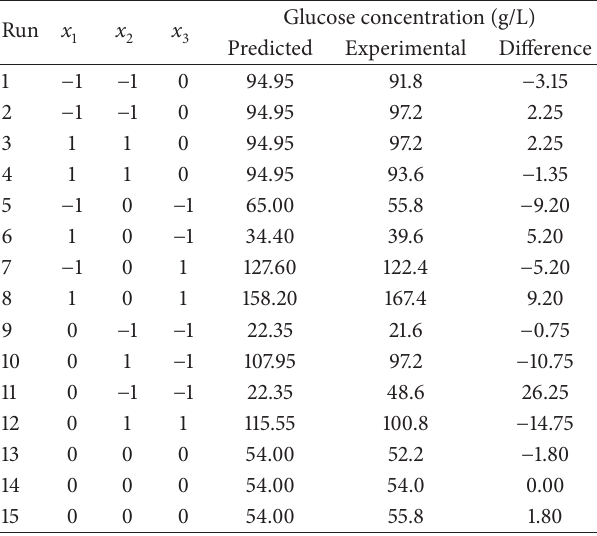
Table 3: Box-Behnken design with experimental and predicted values of glucose